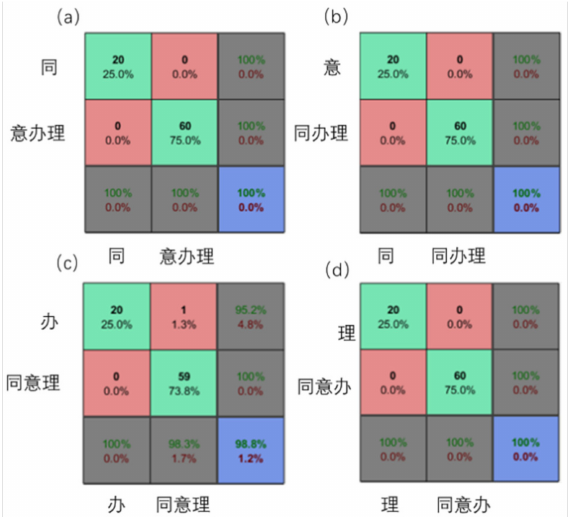
Figure 13. The results of distinguishing one character from others. Distinguish ( a ) “ 同 ” and “ 意 办 理 ” ( b ) “ 意 ” and “ 同 办 理 ” ( c ) " 办 " and “ 同 意 理 ” ( d ) “ 理 ” and “ 同 意 办 ” characters (means “agree to proceed”). Table 4. Different methods for feature classification and recognition for the Chinese Characters “ 同 意 办 理 ” (means “agree to proceed”). Methods of Clas-